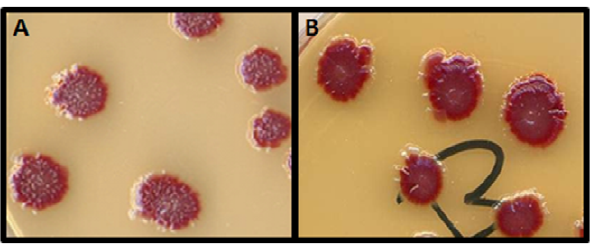
Figure 1. The papillation assay. The strain GLF1 D mutT ::Kan Mu cts produces red colonies (Ara 2 ) on arabinose-tetrazolium chloride agar plates. Ara + revertants are spontaneously produced by mutation and appear as white microcolonies growing out of the surface of the main red colonies. The Ara 2 R Ara + reversion rate can be visualized by the number of white papillae appearing per colony on tetrazolium- arabinose plates incubated for 7 days. A: the mutator strain GLF1 D mutT ::Kan Mu cts forms colonies with a high number of Ara + papillae (white); B: the strain GLF1 D mutT ::Kan Mu cts harboring the mini-Mu plasmid with the chromosomal fragment containing norM forms colonies with a low number of papillae.